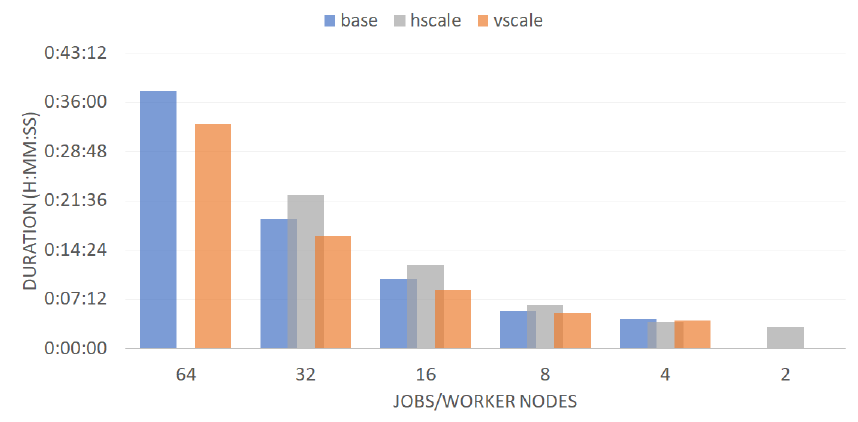
Figure 4. Total duration of each complete batch experiment versus the concurrency per worker node (jobs concurrency/worker nodes in cluster) for the three compared clusters.